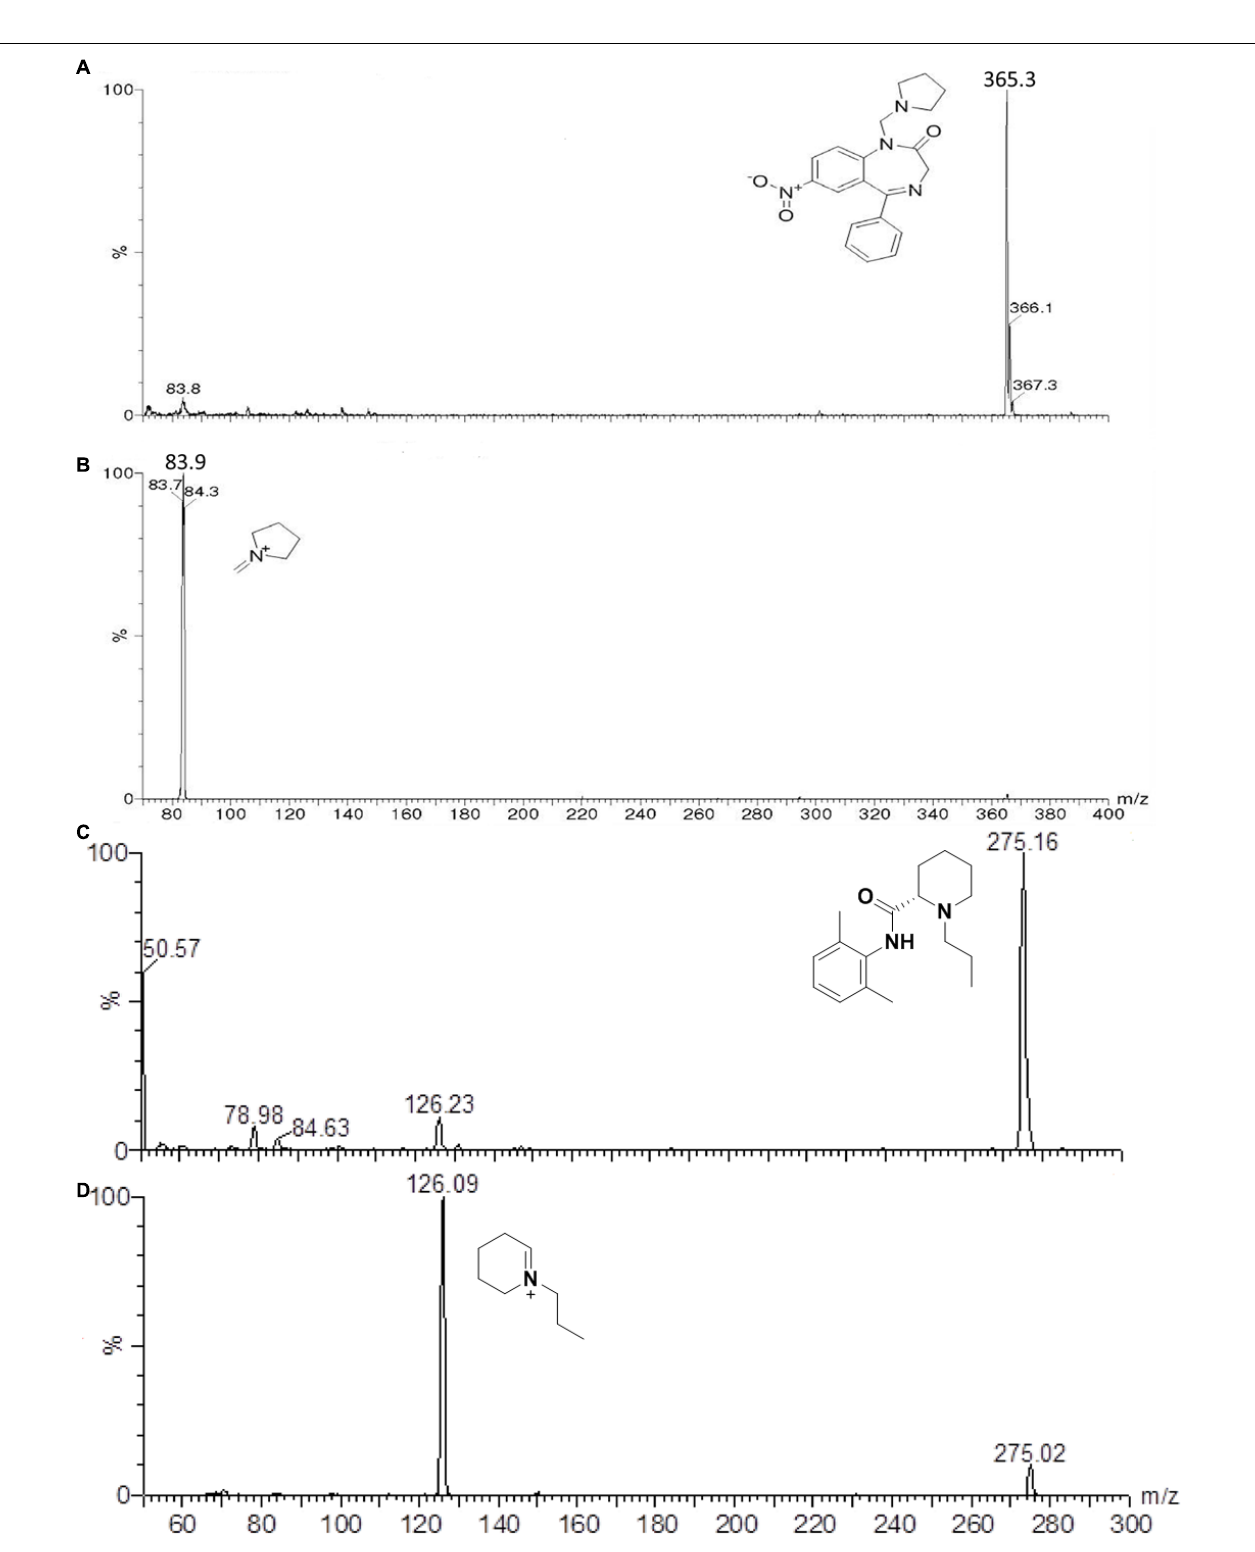
FIGURE 1 | Full scan mass spectrum of the protonated molecular ion of neurounina-1 – m/z = 365.3 (A) , ion product of neurounina-1 – m/z = 83.9 (B) , protonated molecular ion of ropivacaine – m/z = 275.16 (C) , and the ion product of ropivacaine – m/z = 126.09 (D) .